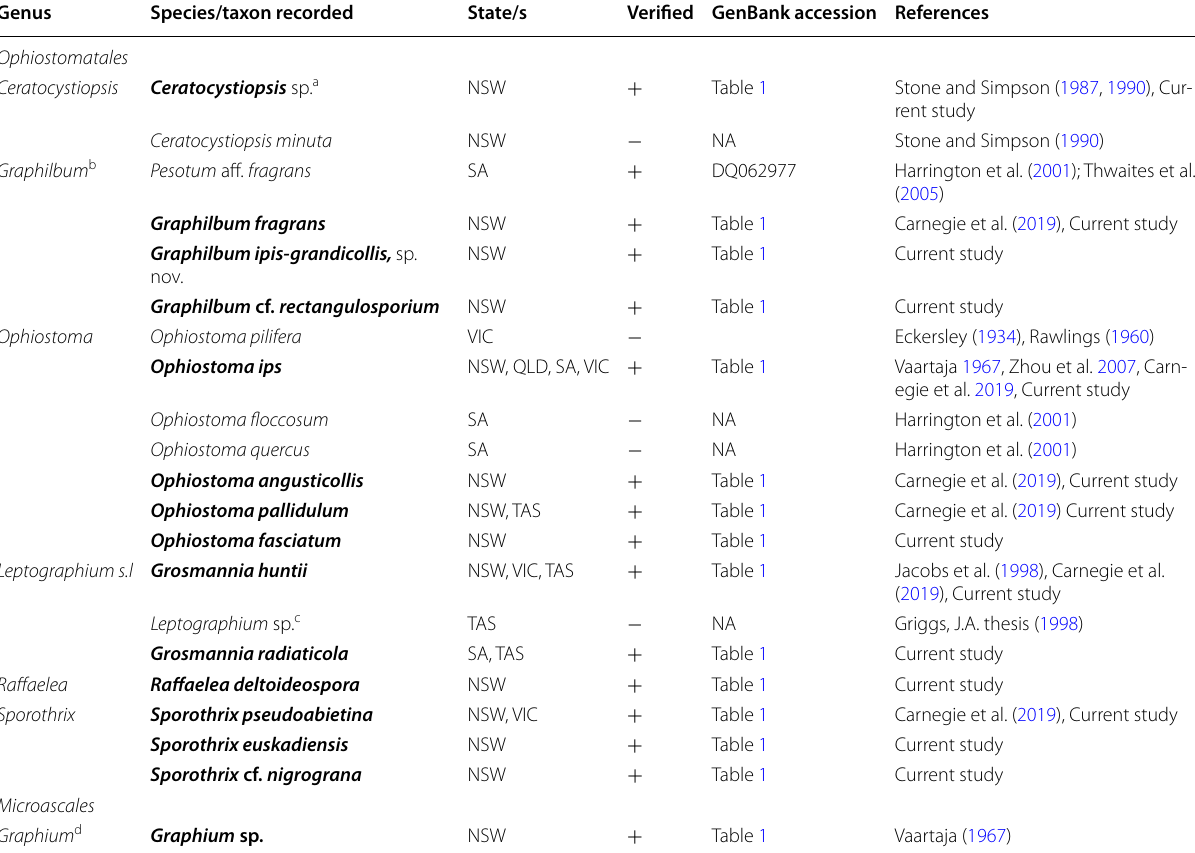
Table 2 Current status list of Australian ophiostomatoid fungi associated with Pinus